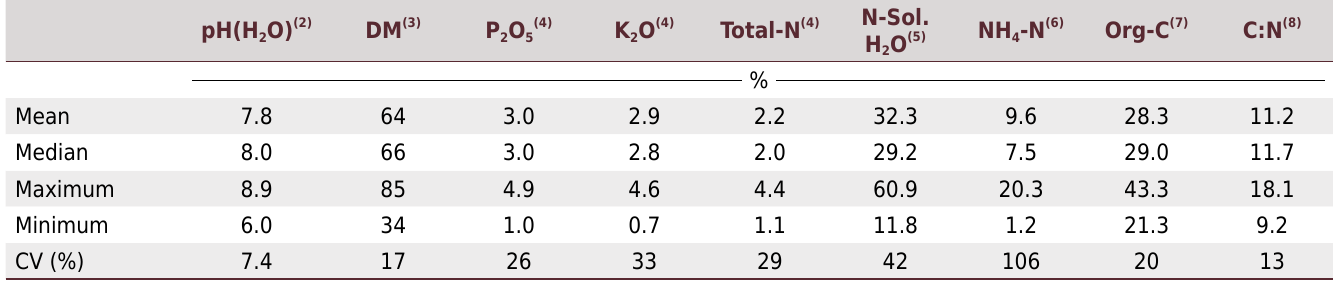
13 (1) n = 165 for DM, N, P (2) pH determined in a water/waste ratio of 20:1; (3) DM = dry 2 O 5 and K 2 O; n = 50 for pH, N-sol. H 2 O and NH 4 -N; n = 20 for org-C; matter, obtained by difference between moist weight and dry weight at 65 °C; (4) Determined after sulfuric digestion (Tedesco et al., 1995); (5) N water soluble relatively to the total N; (6) N in the ammonium form relatively to the total N; (7) organic C determined by moist oxidation (Tedesco et al., 1995); (8) ratio between organic C and total N; CV: coefficient of variation.